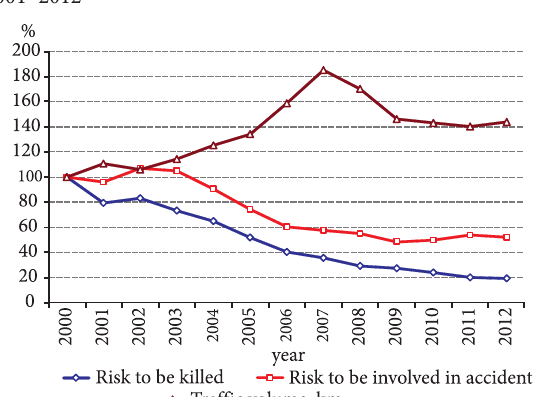
Fig. 2. Traffic volume, risk to be involved in accident and risk